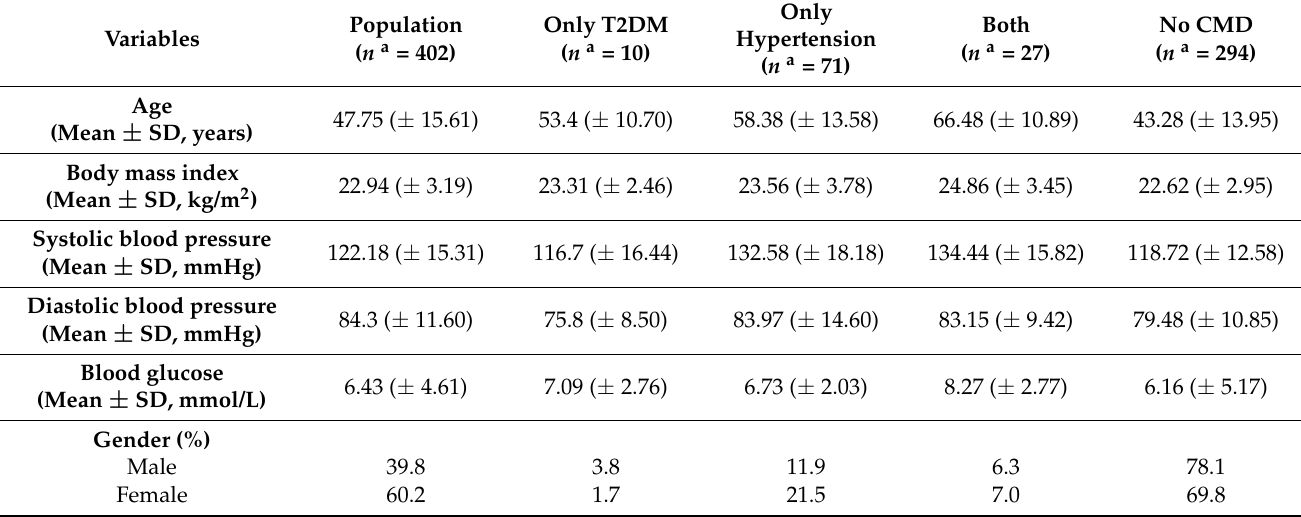
Table 1. Characteristics of participants ( n =